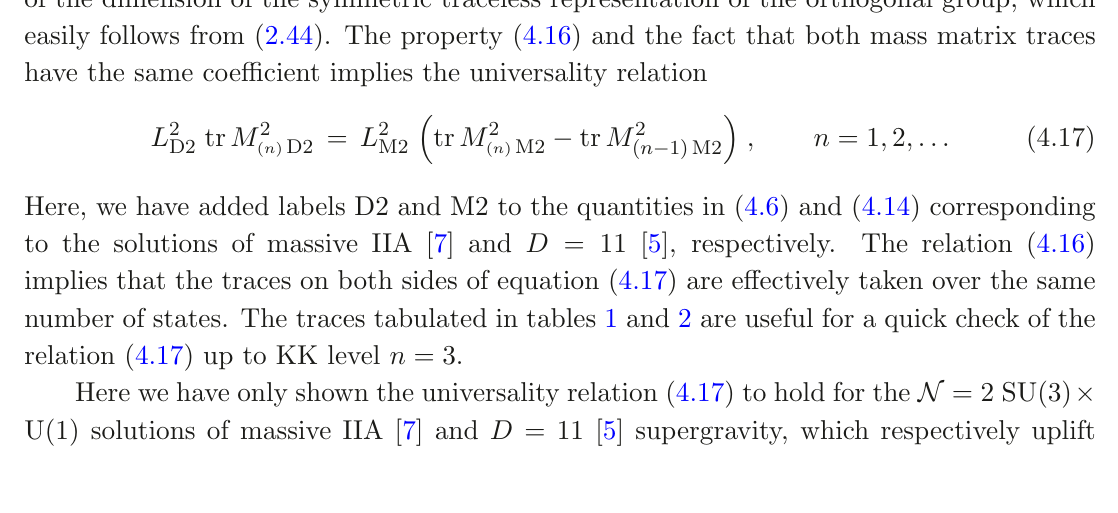
Table 2 . The spectrum of KK gravitons on the CPW D = 11 supergravity up to KK level n = 3, reproduced from [29]. For each state, its SU(3) charges (4.10), degeneracy (4.12), mass (4.9) and dimension computed from (3.2) is given. The trace of the mass matrix (4.14) at level n is also given, and the schematic form of the dual single- trace spin-2 operators. Checked (unchecked) states belong to short (long) graviton supermultiplets of OSp(4 |